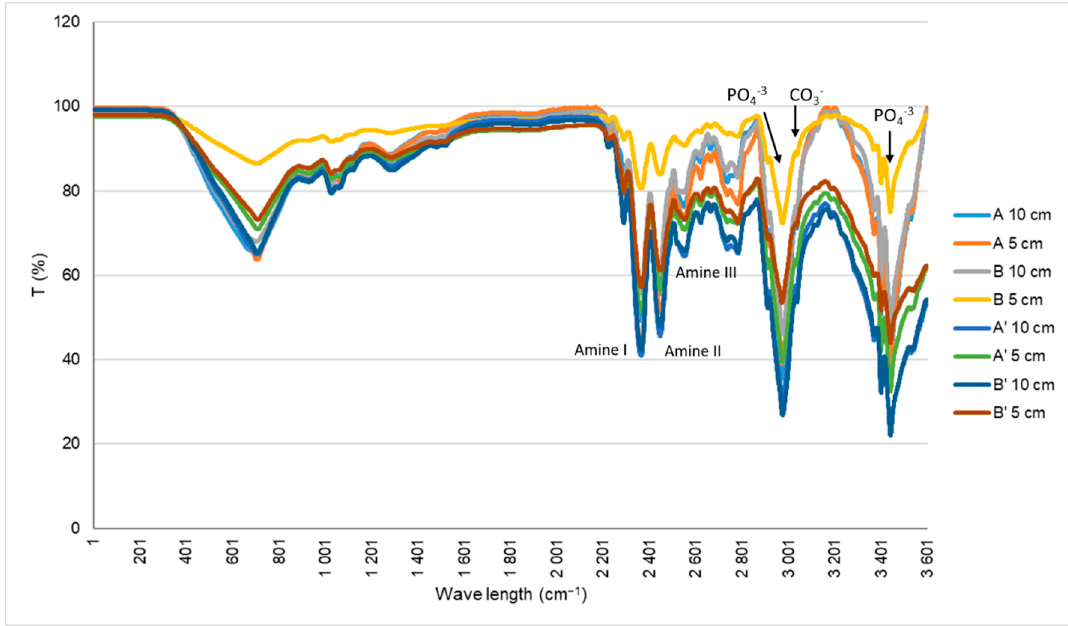
Figure 3. FT-IR spectra of the Coll/nanoHA scaffolds produced with different collagens before (A and B) and after sterilization (A’ and